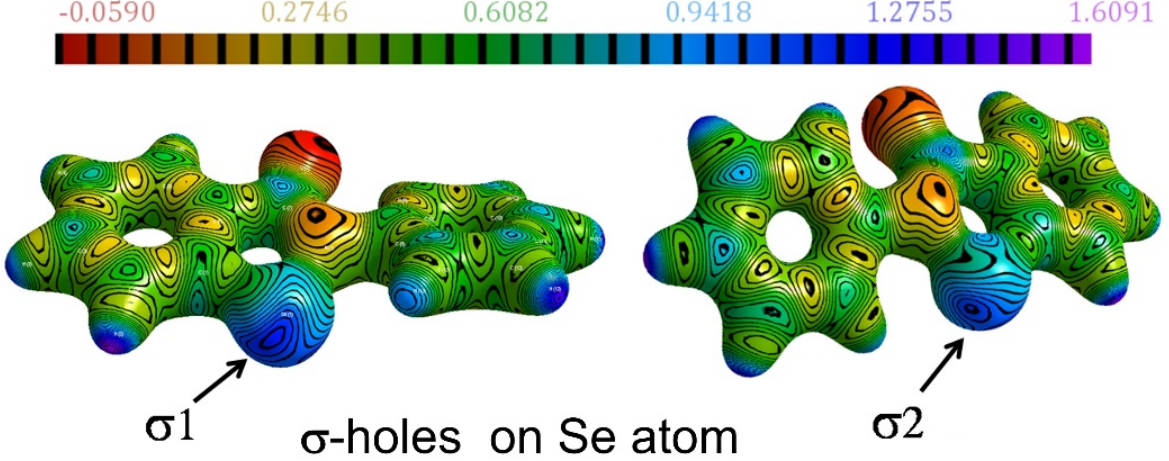
Figure 6. The σ -holes around the Se atom in ebselen , revealed on the ESP mapped on isoelectron density surface (ESP scale in e/Å, the electron density isosurface value =0.5 e/Å 3 ). Adopted from the reference [48] .